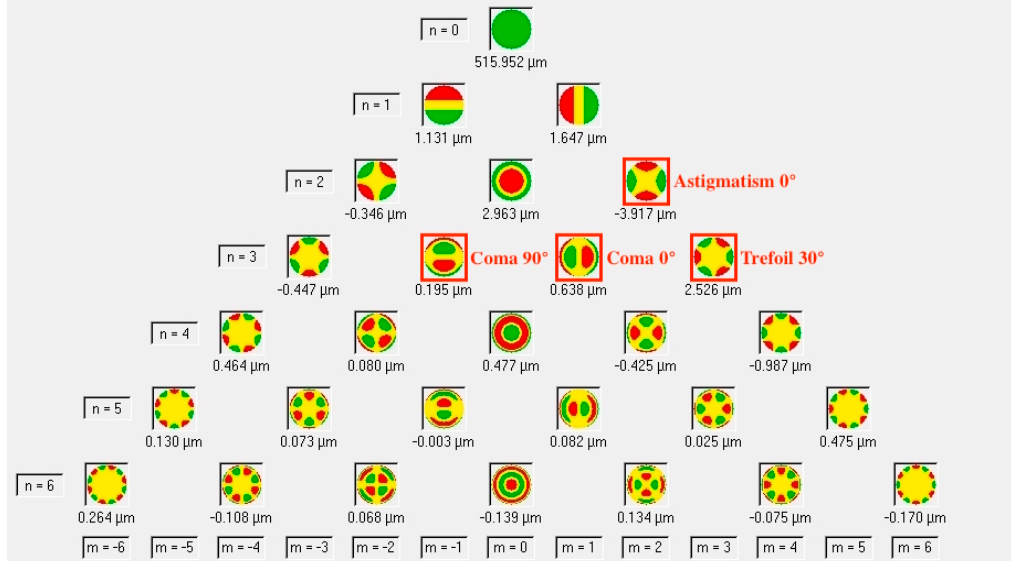
Figure 8. Zernike polynomials as displayed by the Pentacam software. The red framed aberrations increased significantly after exclusive Strontium-/Yttrium-90 beta irradiation of primary pterygia. The majority of HOAs (higher order aberrations) of the 3rd order, but still the overall RMS (root mean square) for HOAs of the 3rd to 6th order showed no statistical significance.